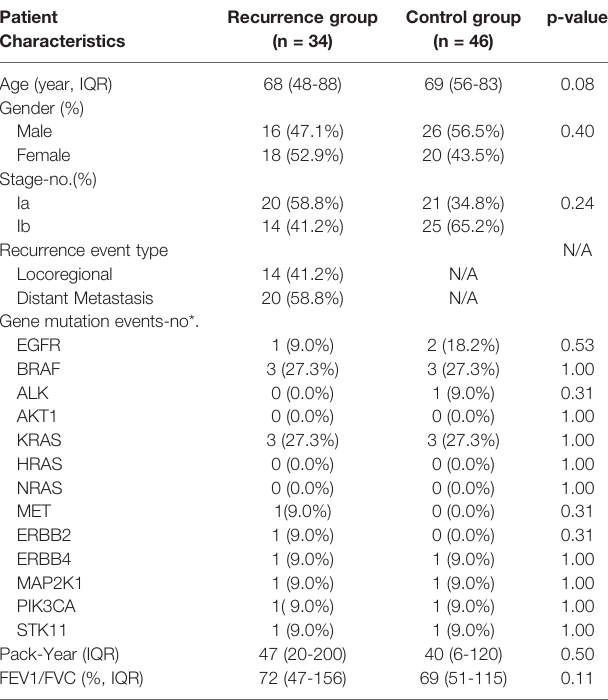
TABLE 1 | Clinical characteristics of patients from TCGA